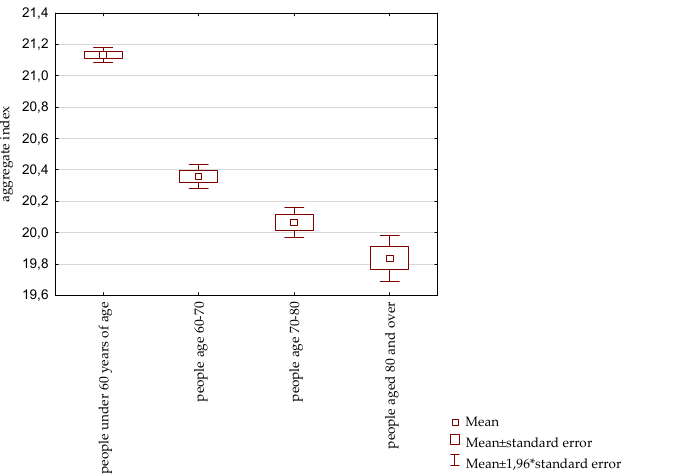
Figure 4. The level of the aggregate indicator in 2018 by age of the person running the household. Source: own elaboration based on data from [136].